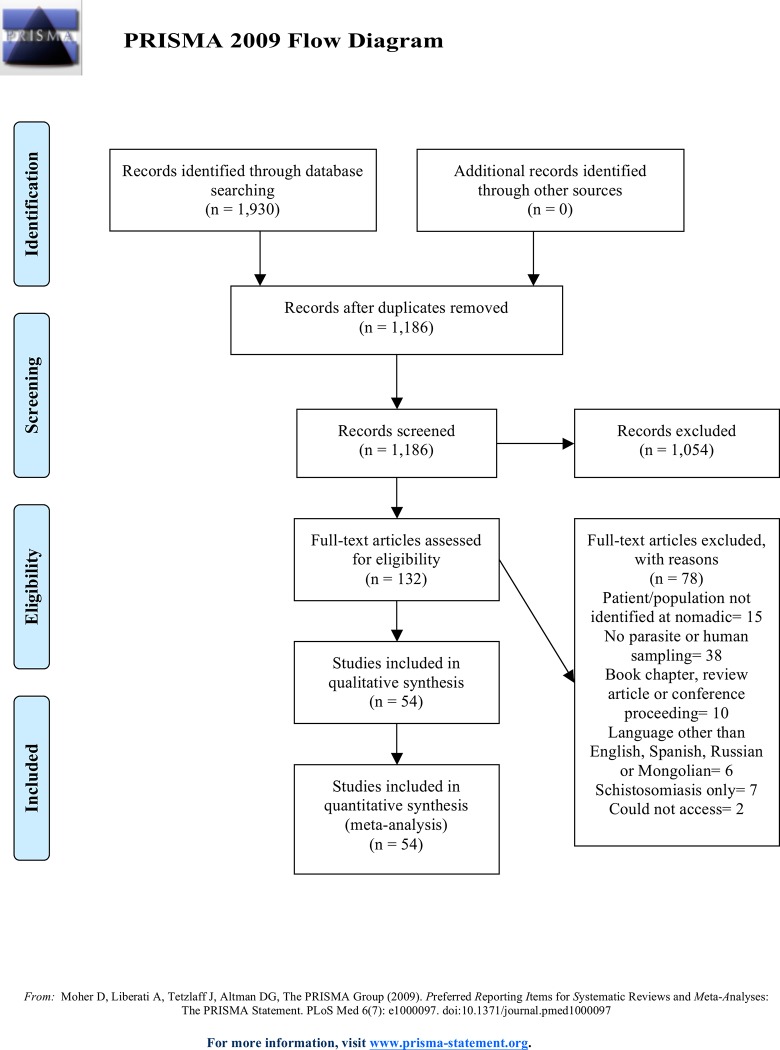
PRISMA flow diagram.